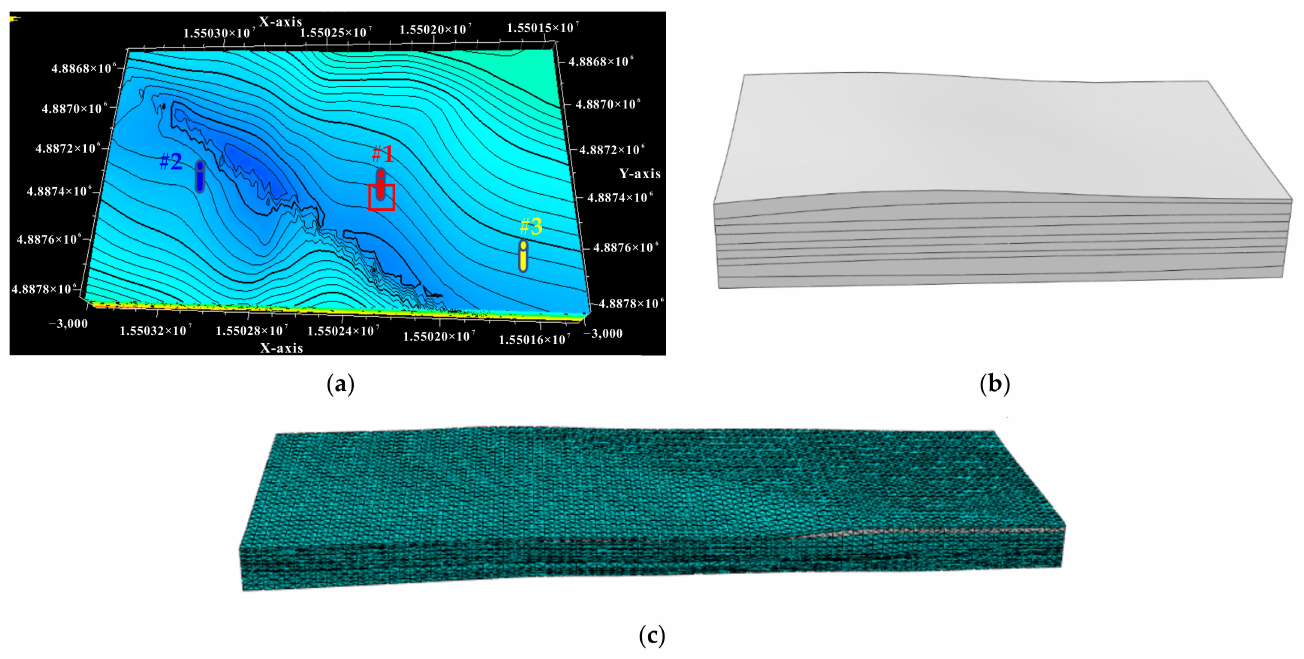
Figure 3. FEM geomechanical modeling of the target reservoir. ( a ) Geological model and well location. ( b ) Geometry of FEM geomechanical model. ( c ) FEM geomechanical model